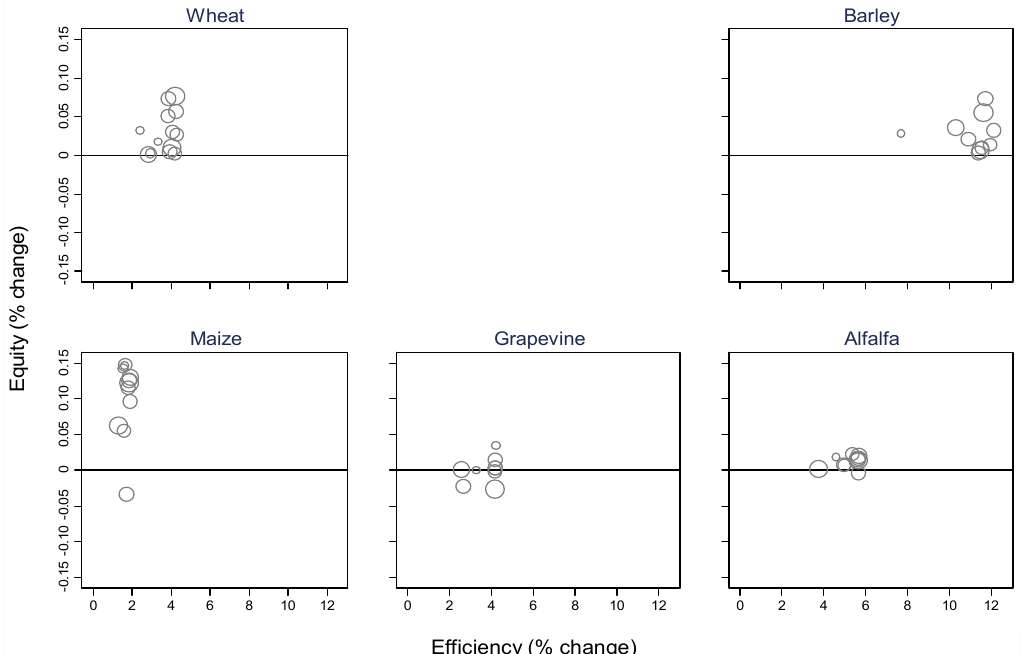
Figure 6. Marginal effects by crop and agricultural GVA of the irrigated area on competitiveness (efficiency) and income distribution (equity) in % change. (Area of symbol proportional to Agricultural GVA of the